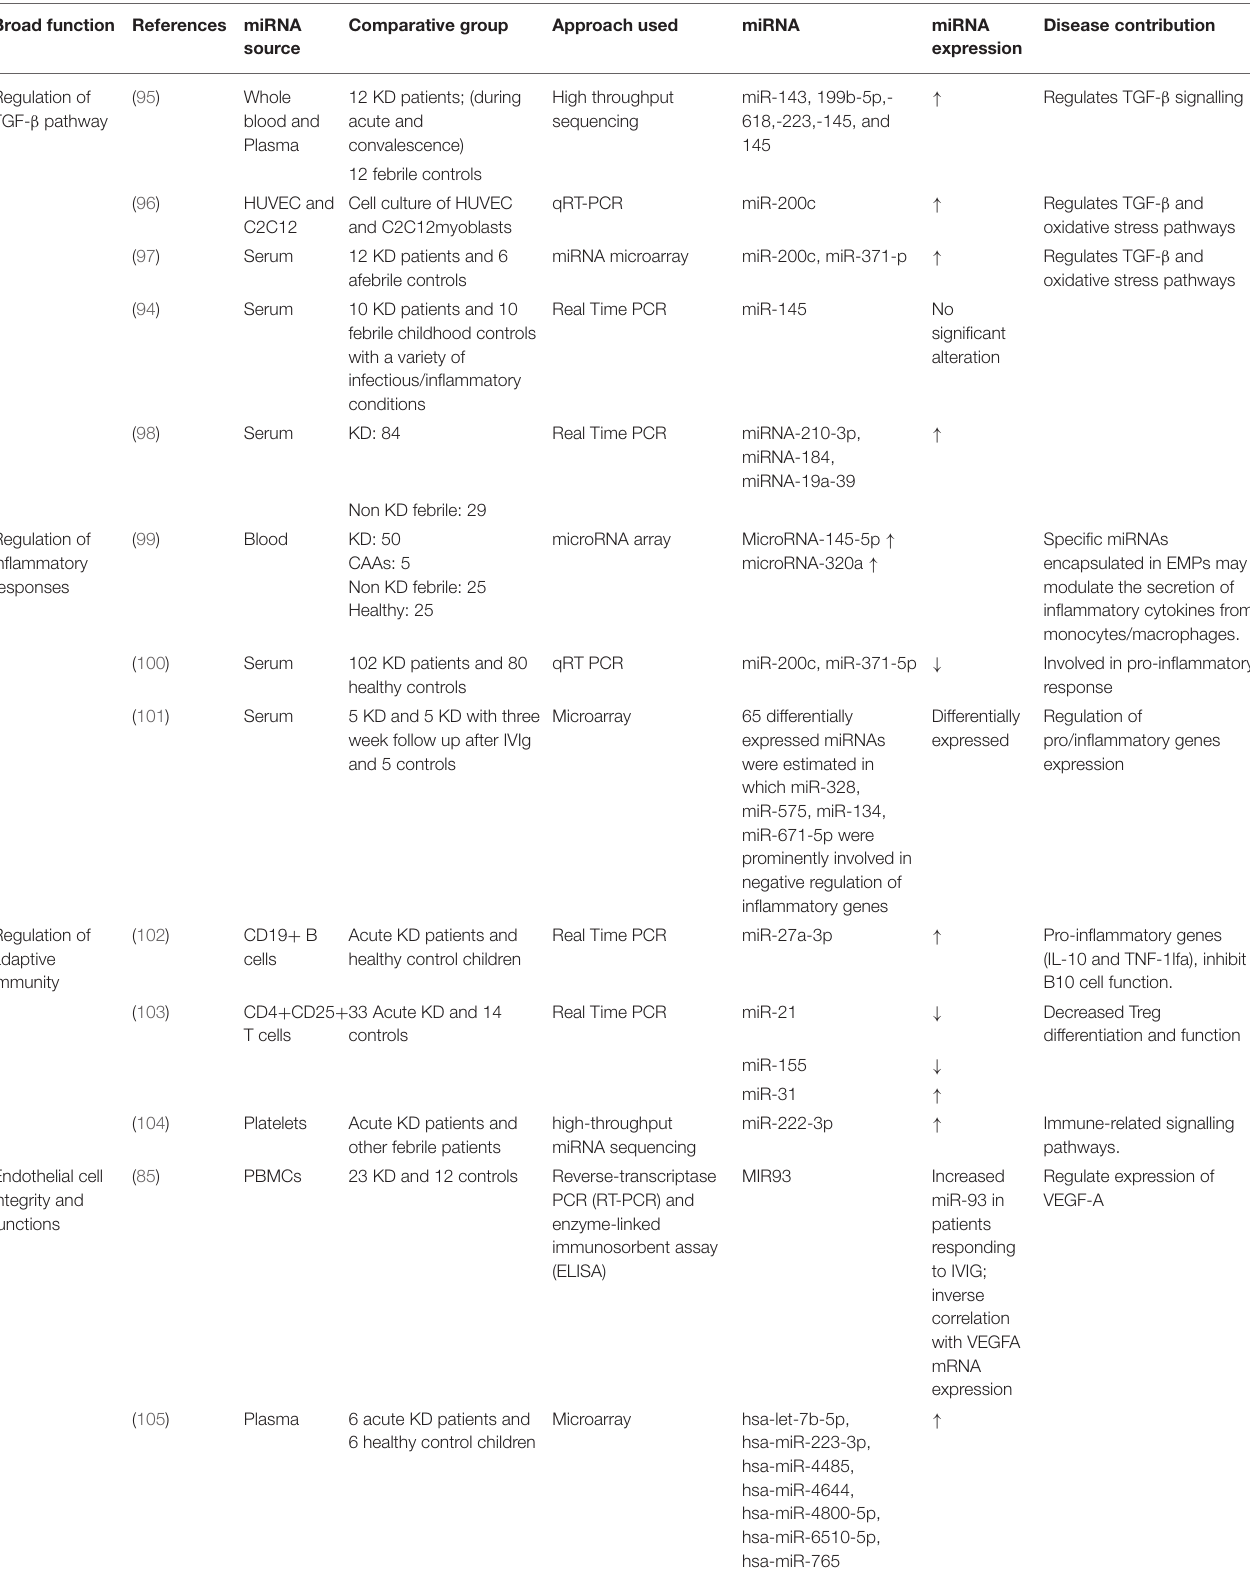
TABLE 2 | Regulation of various genetic and cellular networks involved in KD by miRNAs and lncRNAs. Broad function References miRNA